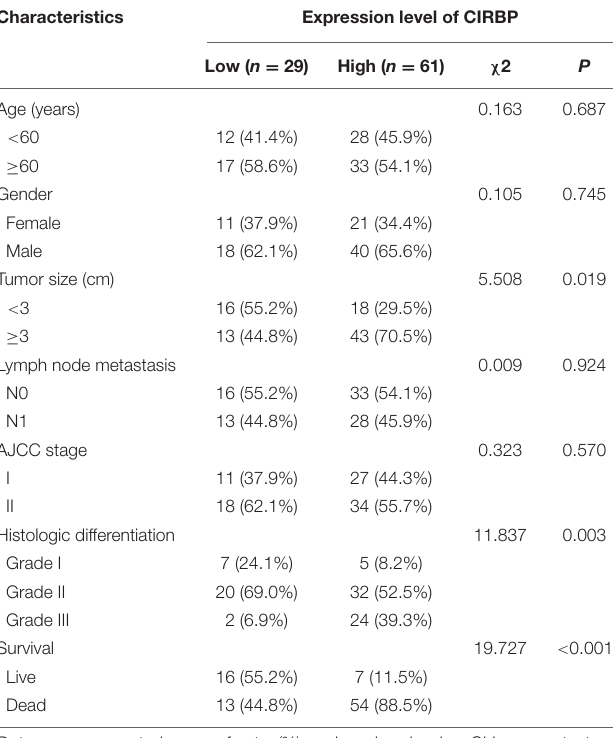
TABLE 1 | Associations of CIRBP expression with clinicopathological factors in pancreatic cancer patients. Characteristics